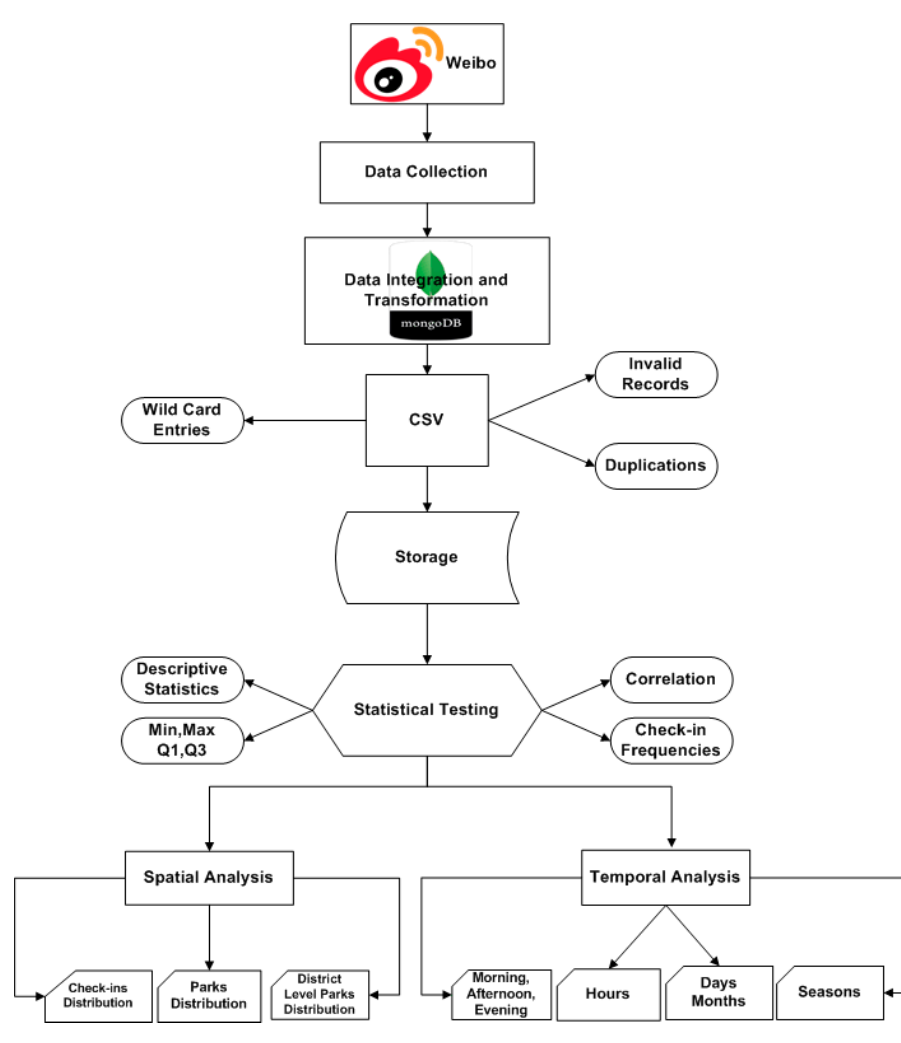
Figure 3. Data analytics framework.